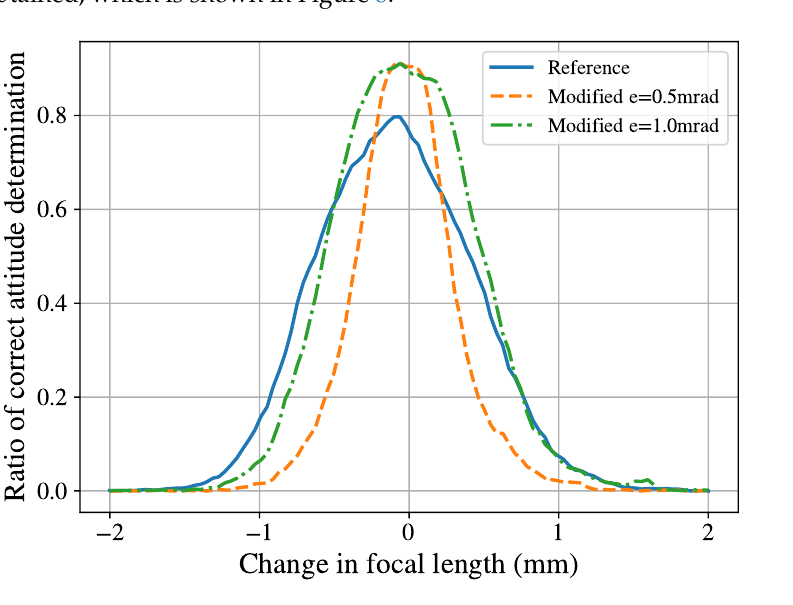
Figure 8. Effect of focal length deviation on the performance of reference and modified algorithms. Here, a field of view of 8° is